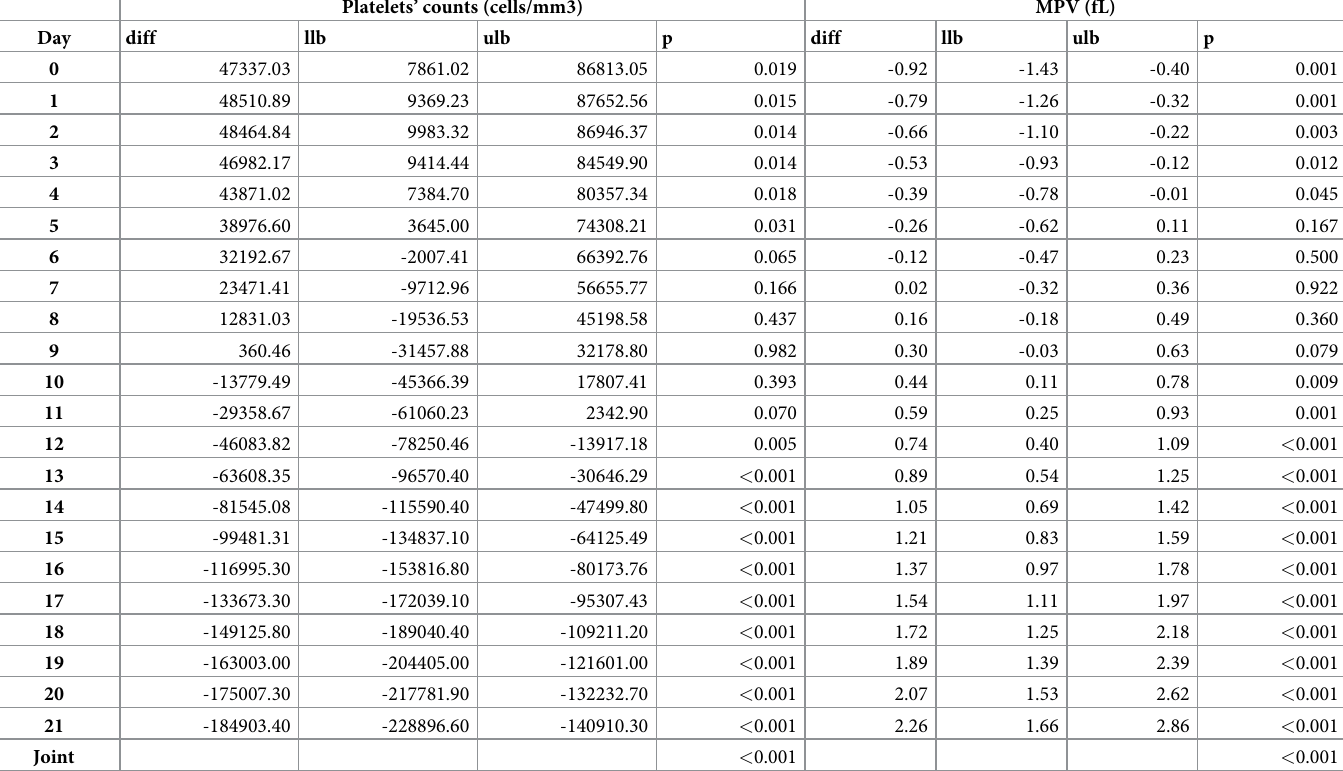
Table 4. Temporal evolution of the differences of platelets’ counts and MPV, between survivors and non-survivors